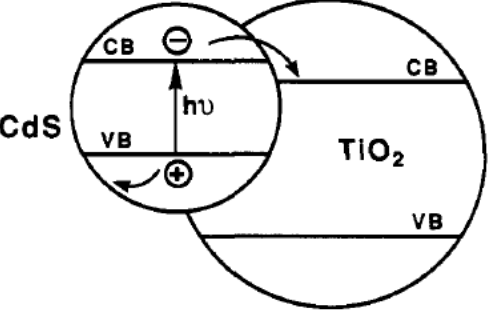
Figure 5. Schematic diagram of the energy levels of CdS-TiO Reprinted (adapted) with permission from ref [55]. Copyright (1990) American Chemical